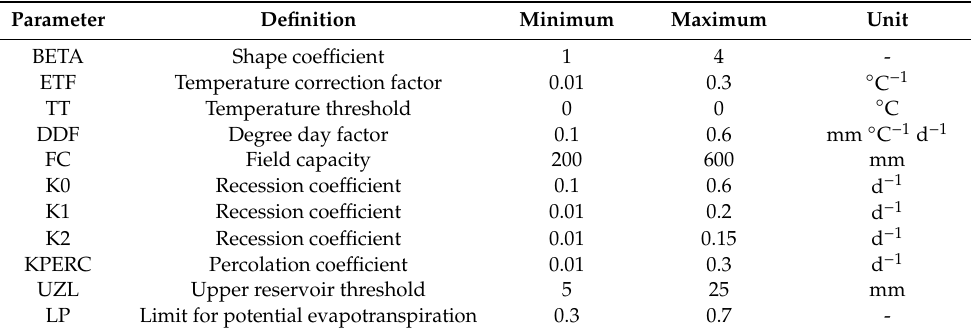
Table 2. HBV model parameter ranges used in